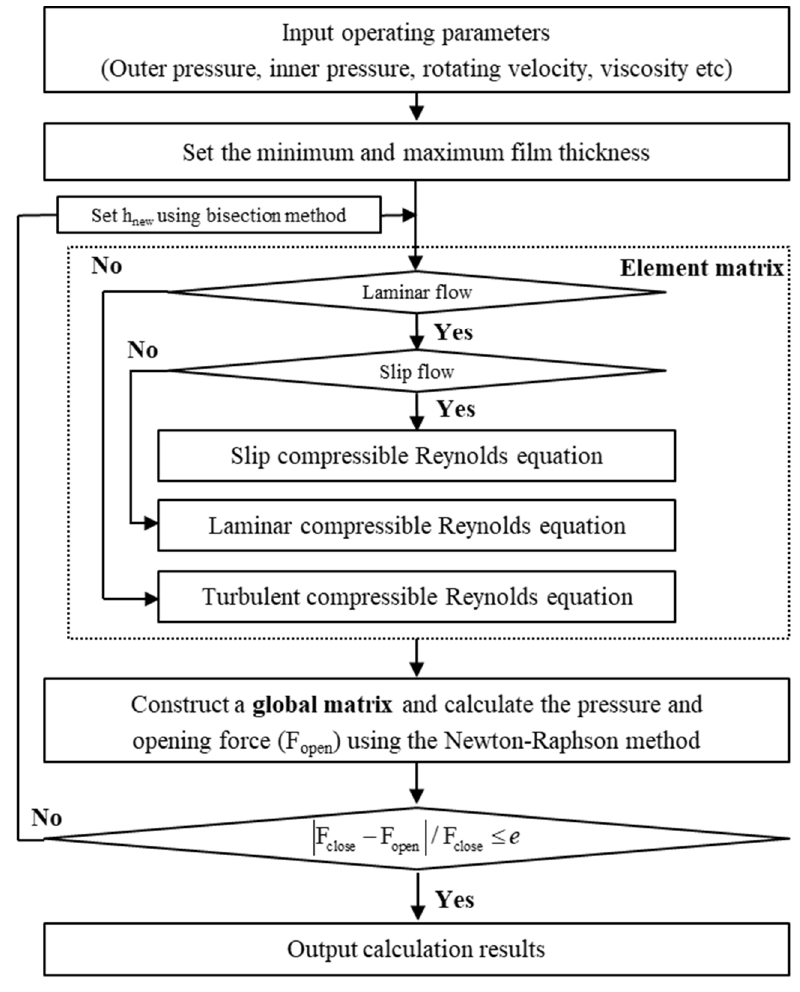
Figure 2. Algorithm of the numerical calculations.